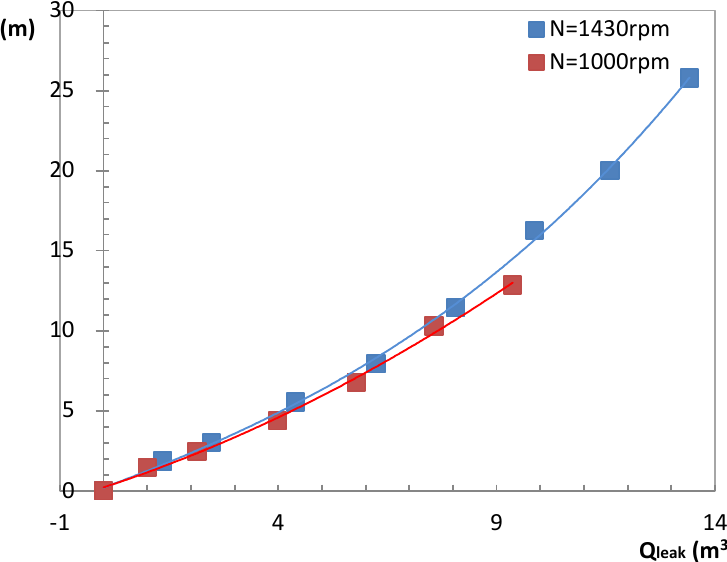
Figure 9. Deduced experimental flow leakage values versus head for two rotational speeds.